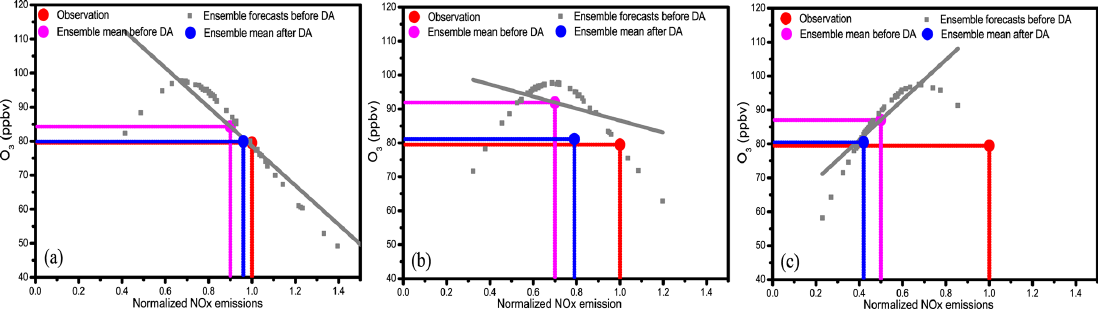
Figure 4. (a–c) O 3 concentrations (ppbv) and NO x emissions (no unit, normalized by the true NO x emission) before and after data assimi- lation and their ensemble samples before DA at 12:00LT on 12 August 2008 in the three ideal ozone data assimilation experiments with the prior NO x emissions underestimated by 10% (a) , 30% (b) , and 50% (c) , respectively. The grey squares denote the ensemble forecast O 3 concentrations corresponding to the perturbations of the NO x emissions (ensemble forecasts before DA), and the magenta dot represents the result of the ensemble mean of the grey squares (ensemble mean before DA). The gray line represents a linear relationship calculated from the ensemble samples of O 3 concentrations and NO x emissions. The red dot represents the true state of the NO x emission and the observed O 3 concentration. The analyzed O 3 concentration and NO x emission are denoted by the blue